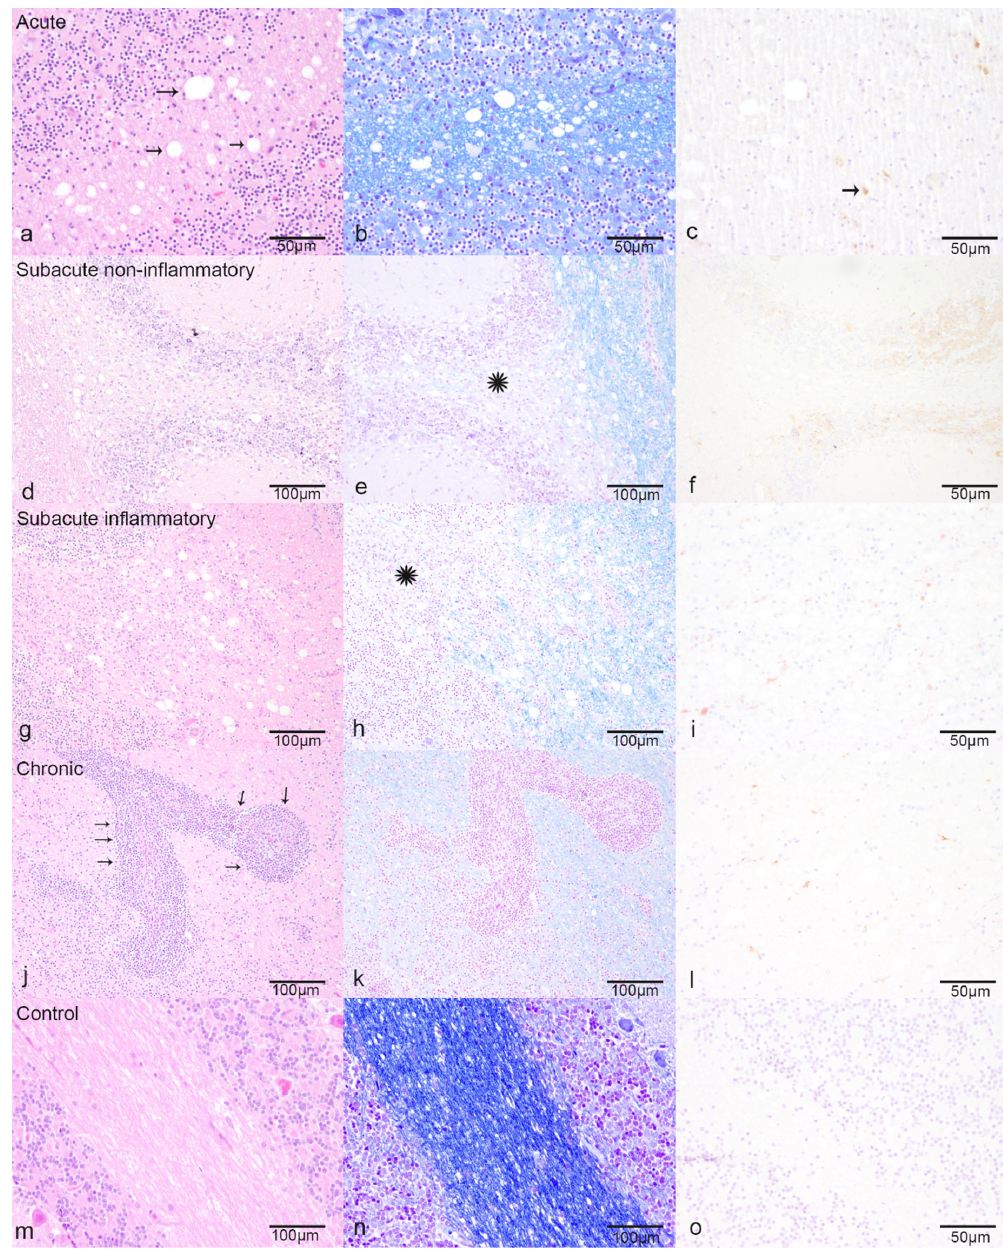
Figure 1. Characteristic pathohistological changes for the different subtypes of Canine distemper virus (CDV)-induced demyelinating leukoencephalitis (CDV-DL): ( a–c) Acute CDV-DL lesions show multifocal dilated myelin sheaths (arrows), mild astrogliosis, and microgliosis, ( a ) Hematoxylin and eosin stain (HE), ( b ) Luxol fast blue (LFB), ( c ) immunohistochemistry for CDV-antigen positive cells (arrows), ( d–f ) Subacute non-inflammatory CDV-DL with beginning demyelination (LFB negative area, asterisk), astrogliosis and microgliosis, ( d ) HE, ( e ) LFB, ( f ) immunohistochemistry for CDV-antigen, ( g–i ) Subacute inflammatory CDV-DL with demyelination (LFB negative area, asterisk) and perivascular inflammatory infiltration up to three cell layers, ( g ) HE, ( h ) LFB, ( i ) immunohistochemistry for CDV-antigen, ( j – l ): Chronic CDV-leukoencephalitis with ongoing demyelination and severe perivascular inflammatory infiltration (arrows) more than three cell layers, ( j ) HE, ( k ) LFB, ( l ) immunohistochemistry for CDV-antigen, ( m – o ): Controls, ( m ) HE, ( n ) LFB, ( o ) immunohistochemistry for CDV-antigen.